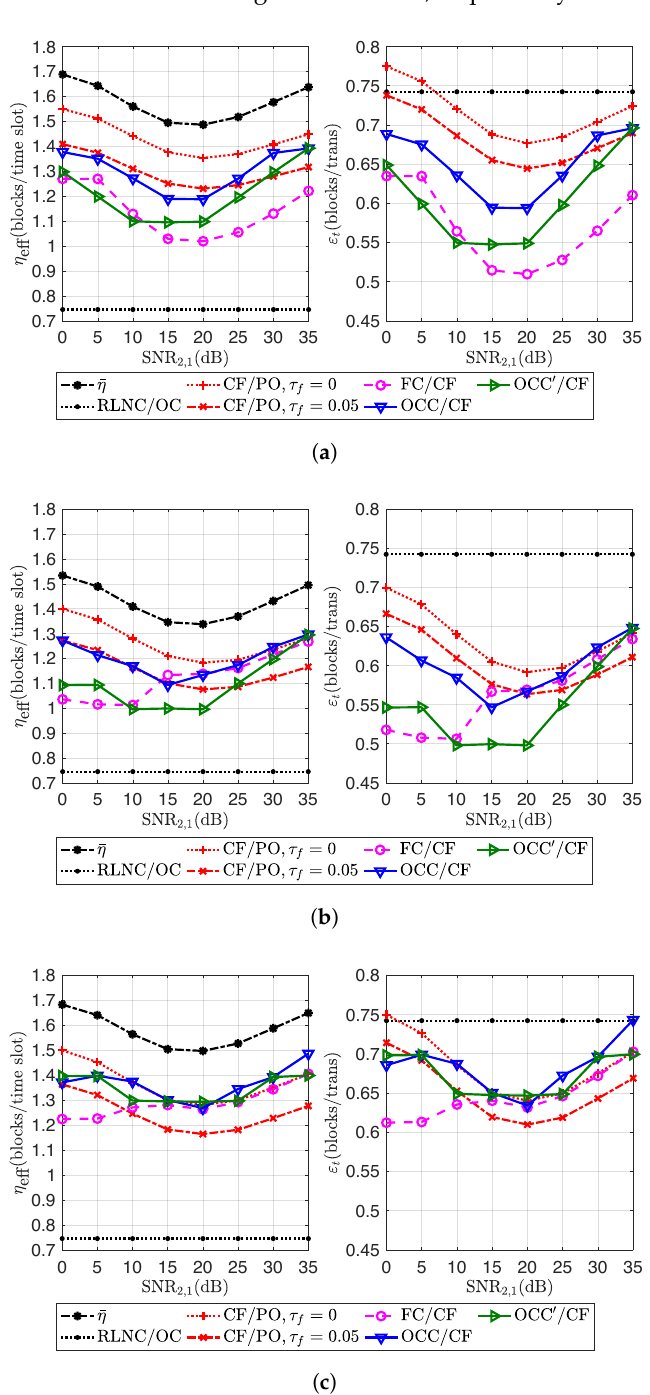
Figure 10. Channel efficiency and transmission efficiency for Scenario 1. ( a ) SNR 1,2 = 5 dB; ( b ) SNR 1,2 = 20 dB; ( c ) SNR 1,2 = 35